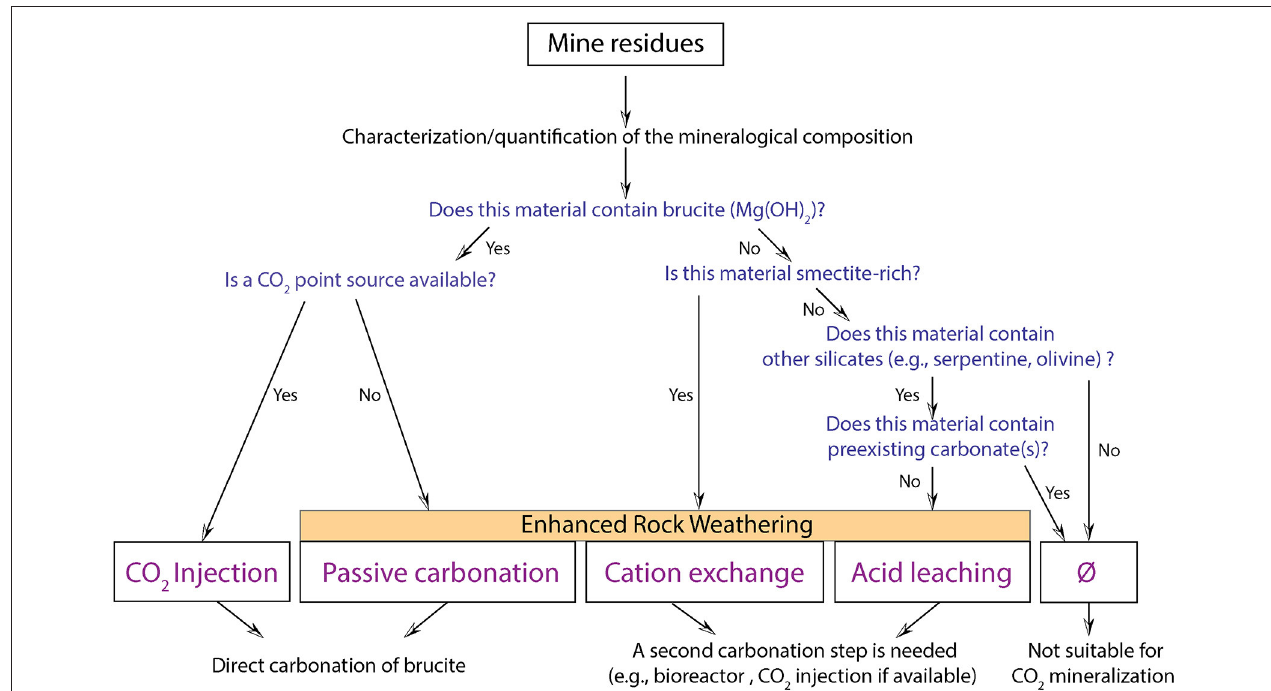
FIGURE 8 | Decision tree for carbonation of mine residues. Whether CO 2 injection, passive carbonation, cation exchange or acid leaching can be used depends on the mineralogy of the processed kimberlite and the availability of a CO 2 point source.